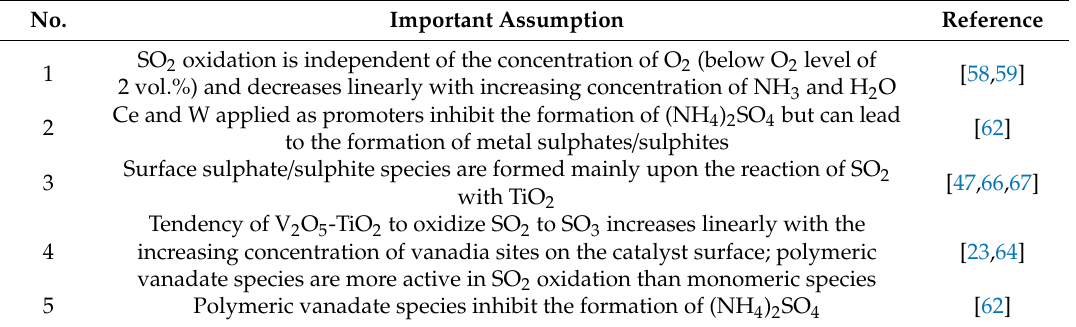
Table 1. The most important findings on the interaction of SO 2 with V 2 O 5 -TiO 2